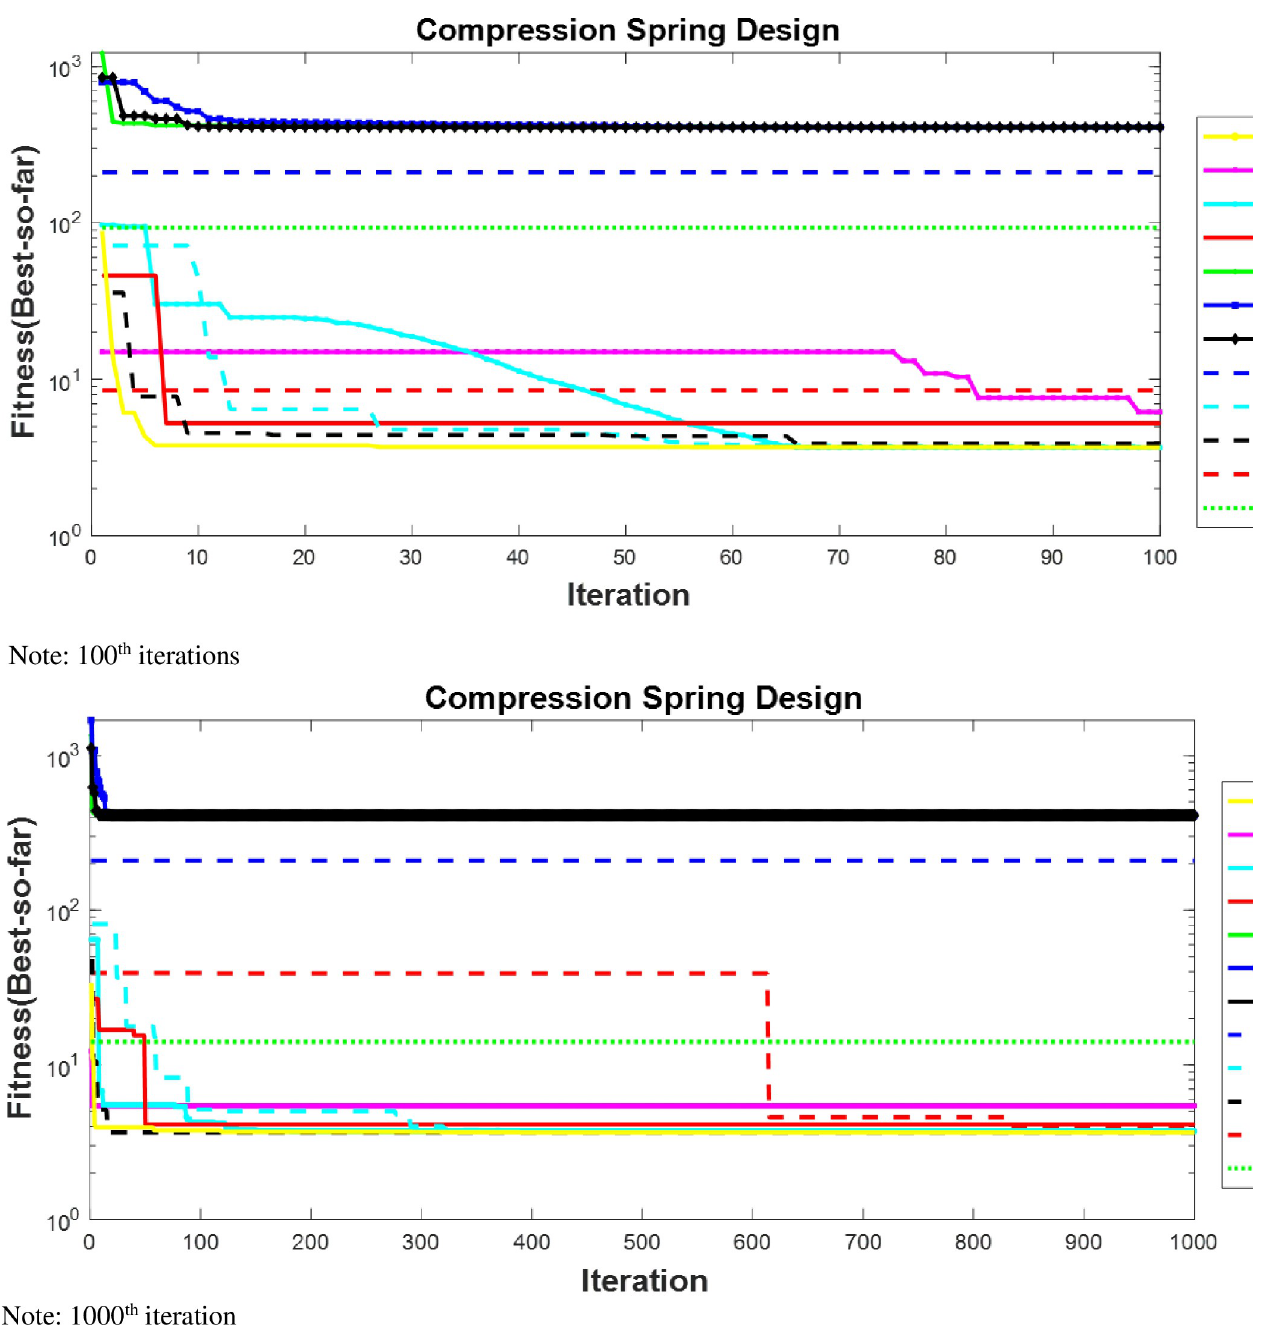
Fig 9. Convergence curves of CSD. Note: 100 th iterations. Note: 1000 th iteration.